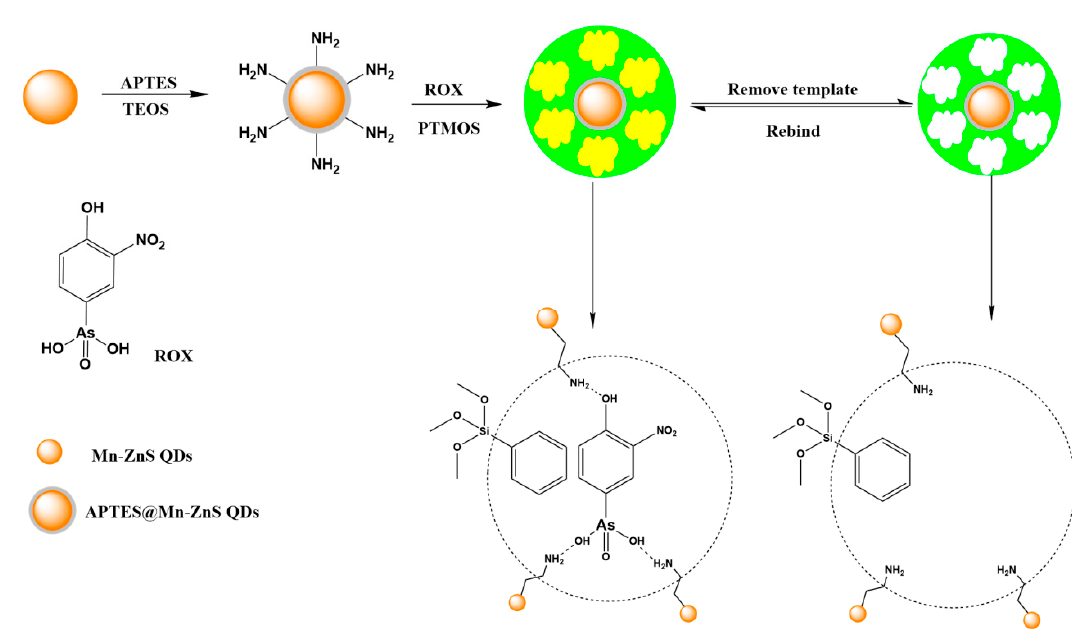
Figure 1. Schematic illustration of the preparation procedure of MIPs@Mn-ZnS QDs for ROX.